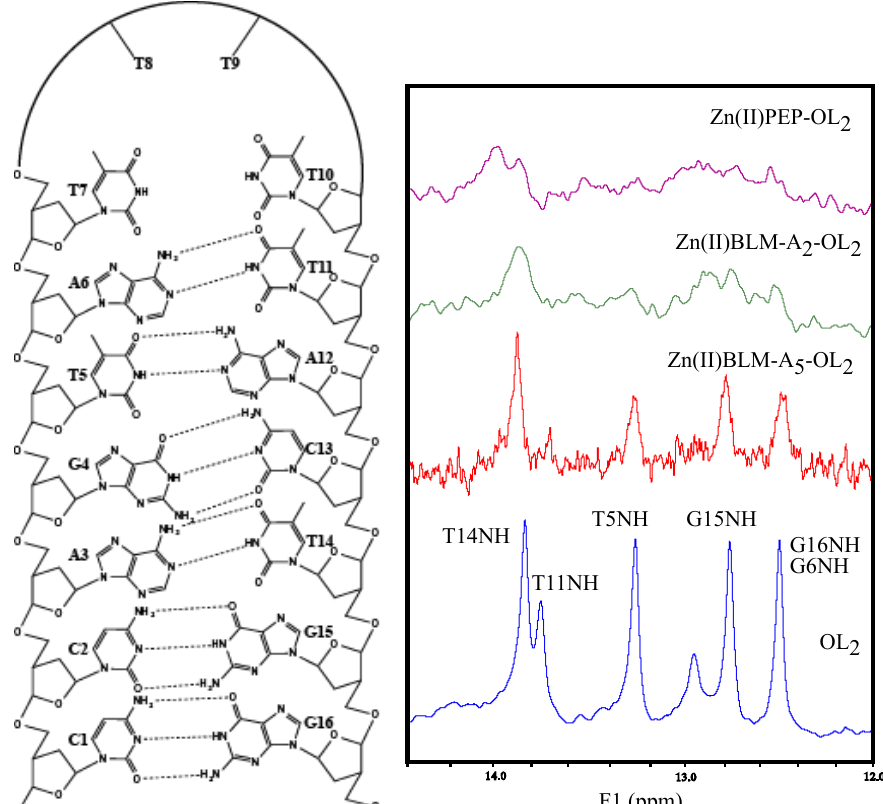
Figure 2. Left: Native OL 2 . Right : Imino region of the 1D 1 H-NMR spectra in H 2 O collected at 5 °C for free OL 2 and OL 2 bound to Zn(II)BLM-A 2 , -A 5 , and Zn(II)PEP. Zn(II)BLM:DNA molar ratio 1:1.